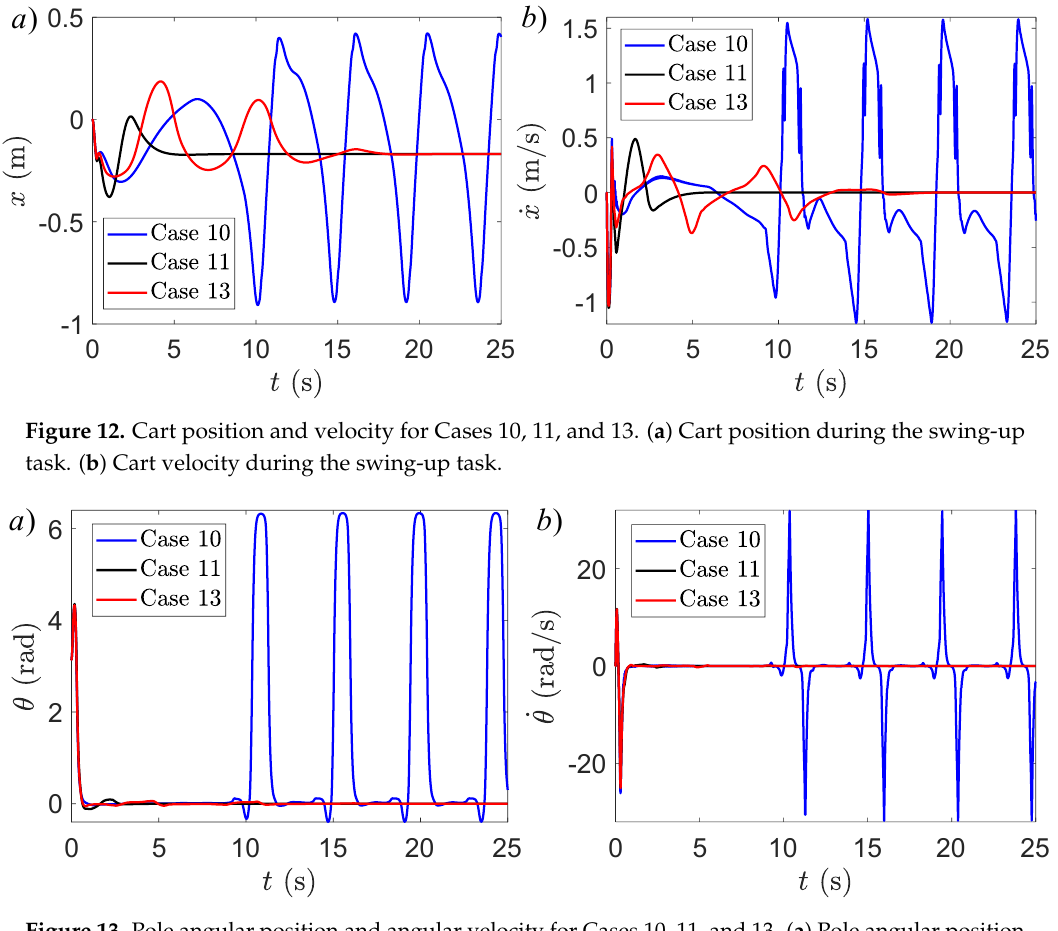
Figure 13. Pole angular position and angular velocity for Cases 10, 11, and 13. ( a ) Pole angular position during the swing-up task. ( b ) Pole angular velocity during the swing-up